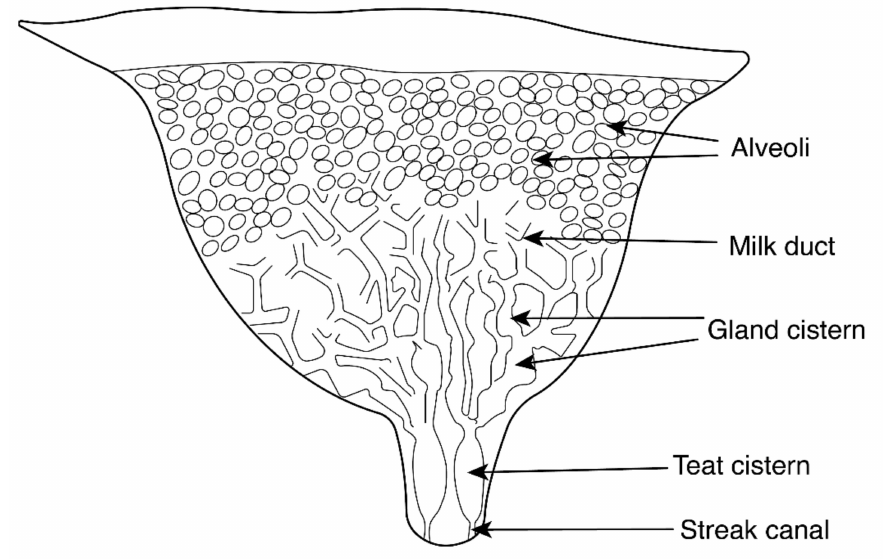
Figure 2. Schematic representation of a half udder of a donkey mare (own drawing Kaskous, S., 2022). Between the events of milk removal by suckling or milking, milk accumulates in the udder and is stored within two compartments: the cistern (including teat and gland cistern and in large and medium milk ducts) and the alveoli (alveoli and small milk ducts). The udder cistern of donkey mare is very small and consists of several pockets that open directly into the teat, rather than a single cistern